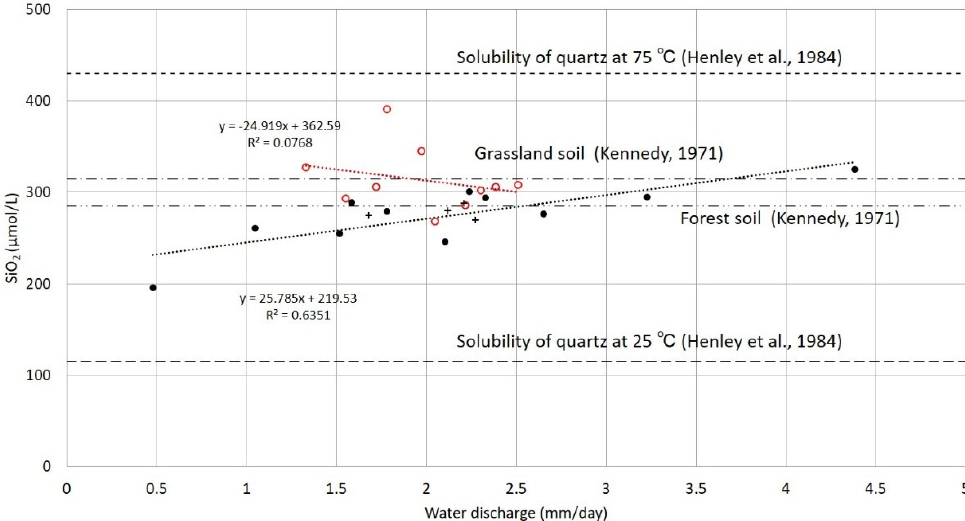
Figure 4. The relationship between the water discharge (mm/day) and the dissolved silica concentration (µmol/L). (In Figures 4, the black circle shows the data of the left bank tributaries, the red circle shows the data of the right bank tributaries and the plus sign shows the mainstream data. The values of solubility of quartz at 25 and 75 °C are shown in Figure 4 as reference [22]. The reference values of grassland soil and forest soil are also shown